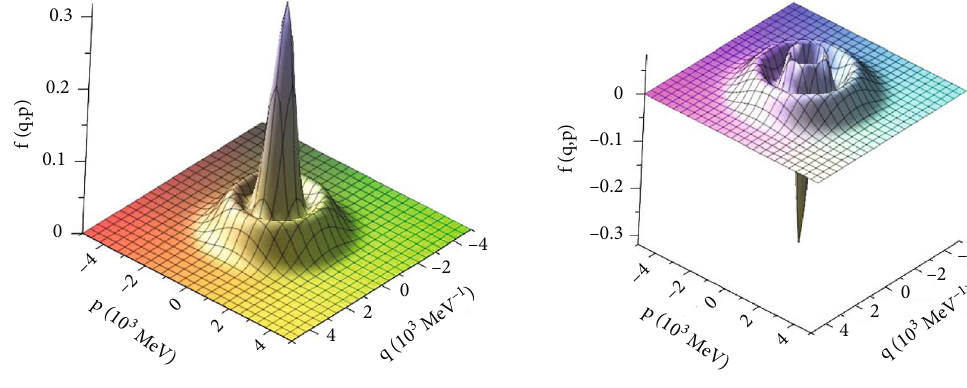
Figure 3: Wigner function for the energy levels n = 0 and 1 for the c (cid:1) c